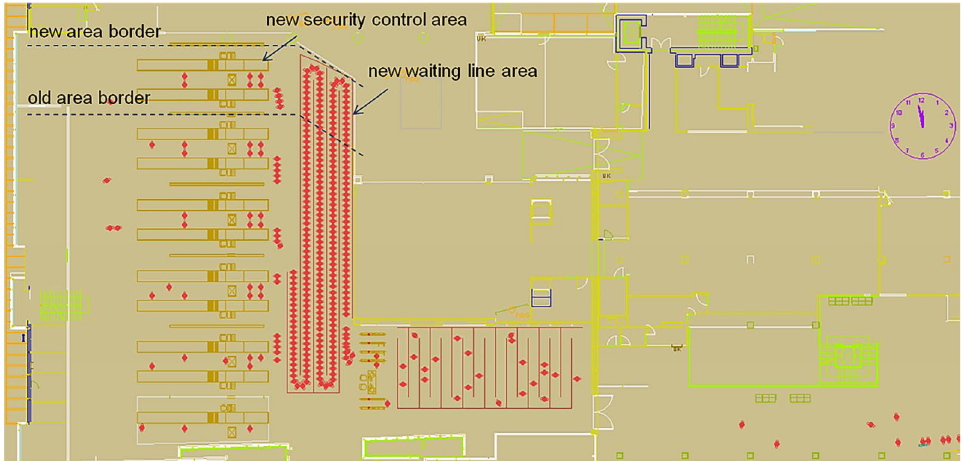
Figure 13. Visualisation of results for Scenario 3